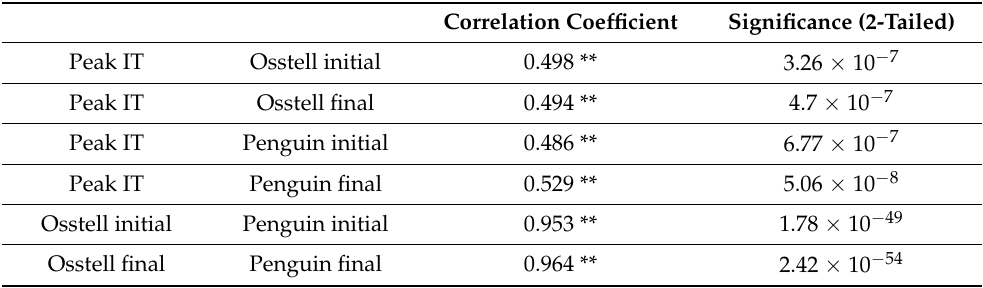
Table 4. Correlation coefficient between the different device measurements using Spearman’s rho correlation coefficient for all the different tested parameters (IT = insertion torque). ** The correlation is significant at the 0.01 level (2-tailed).